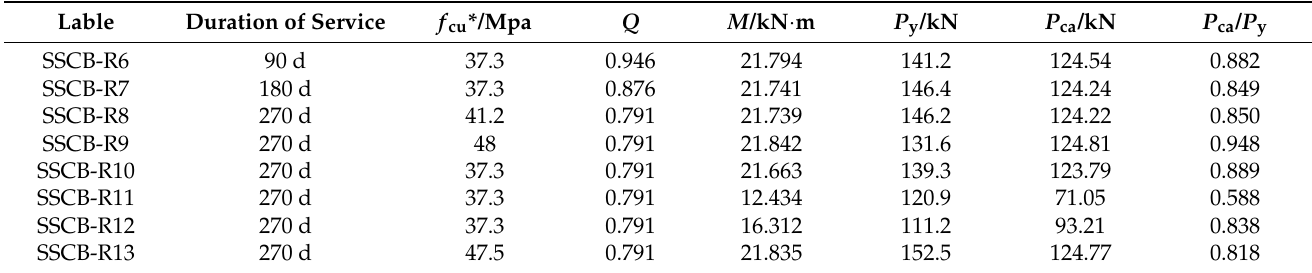
Table 3. Calculated results of the specimen compared with the test